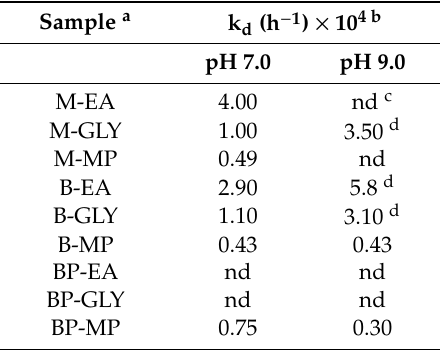
Table 5. Kinetic rate constants of the retro aza-Michael reaction at 25 ◦ C.